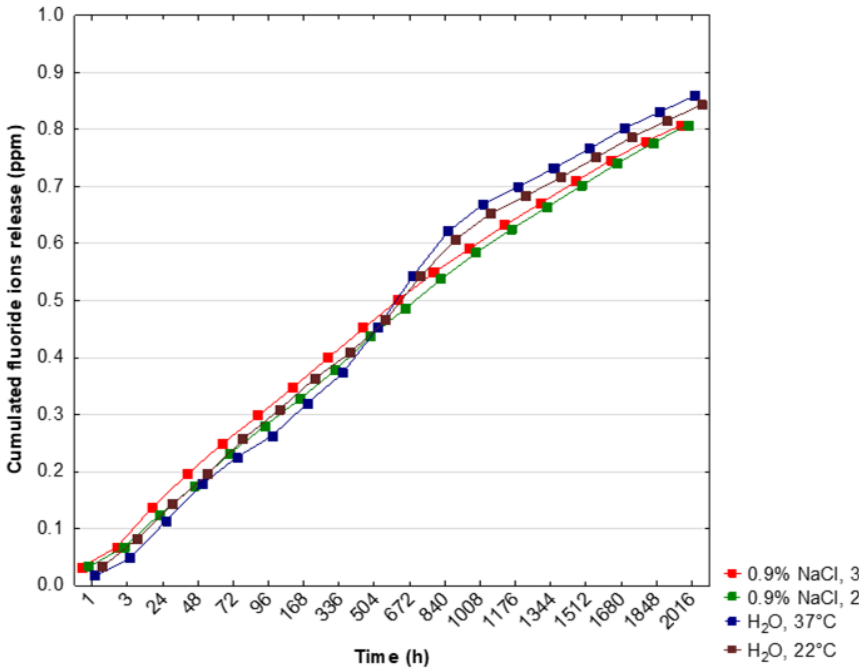
Figure 6. Cumulated fluoride ion release into a saline solution or deionized water. Dots represent the means of measurements.